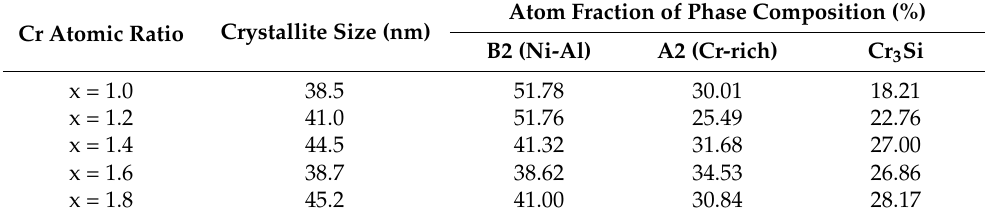
Table 1. Changes in crystallite size and atom percentage of phase composition of AlSi 0.5 Cr x Co 0.2 Ni. (x = 1.0, 1.2, 1.4, 1.6, and 1.8) high entropy alloys.